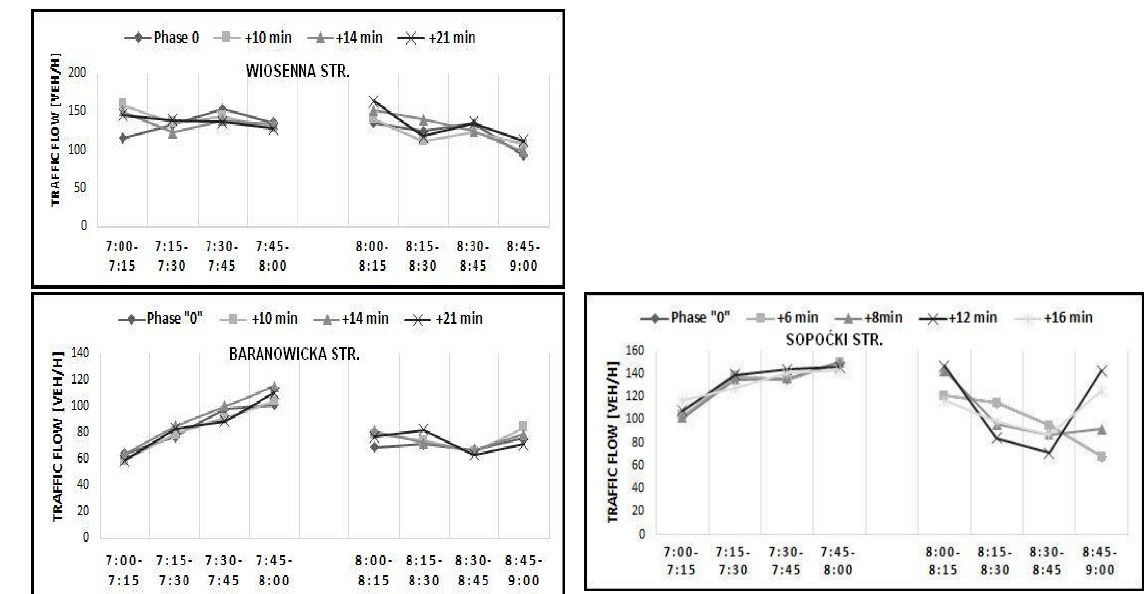
Information on traffic flow intensity variations caused by artificially elongated travel time displayed on the VMS boards present similar trends to those found during everyday operation of the VMSs. In the case of main routes (Figure 7), in the first hour traffic intensity volumes show smooth upward trends which in the second hour change into downward ones. In the case of alternative routes (Figure 8), the pattern of traffic flow variations are